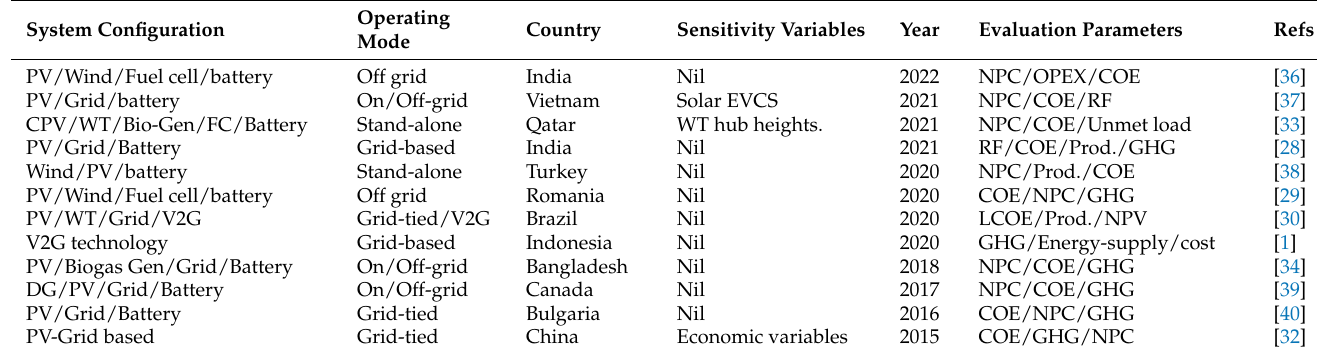
Table 1. The EVCS system designs and sensitivity analyses conducted in previous works in the open